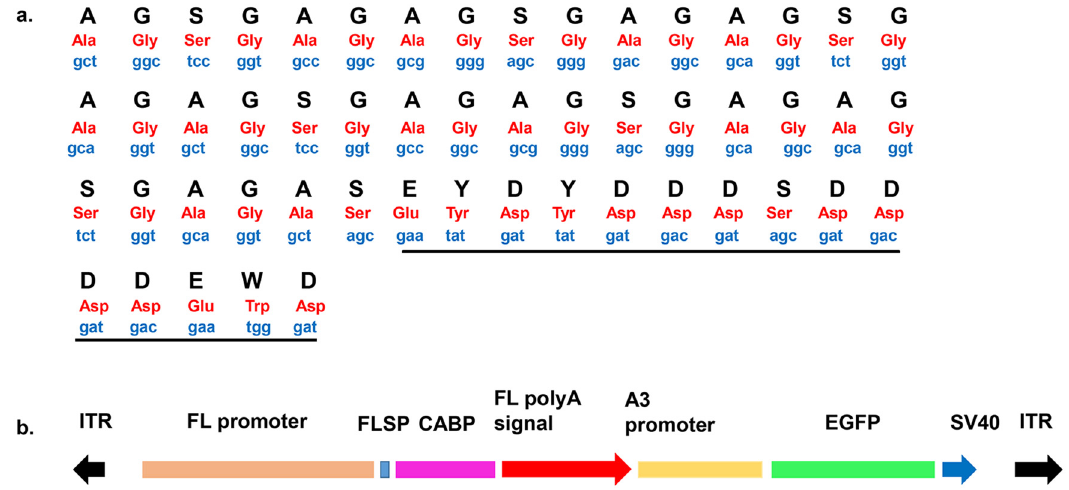
Fig 1. The calcium binding protein sequence and transgenic experiment vector. One copy of the sequence [(AGSGAG) 6 ASEYDYDDDSDDDDEWD] 2 (A). (AGSGAG) n is the silk fibroin repetitive domain from B . mori . The calcium- binding protein sequence from the shell nacreous matrix protein MSI60 is marked by a black line. The vector used for the transgenic experiment (B). ITR, inverted terminal repeats of PB transposon; FL, fibroin light chain; FLSP, signal peptide of fibroin light chain; CABP, calcium-binding protein; A3, Bombyx mori A3 cytoplasmic actin gene; EGFP, enhanced green fluorescence protein; SV40, 3 ’ -untranslated